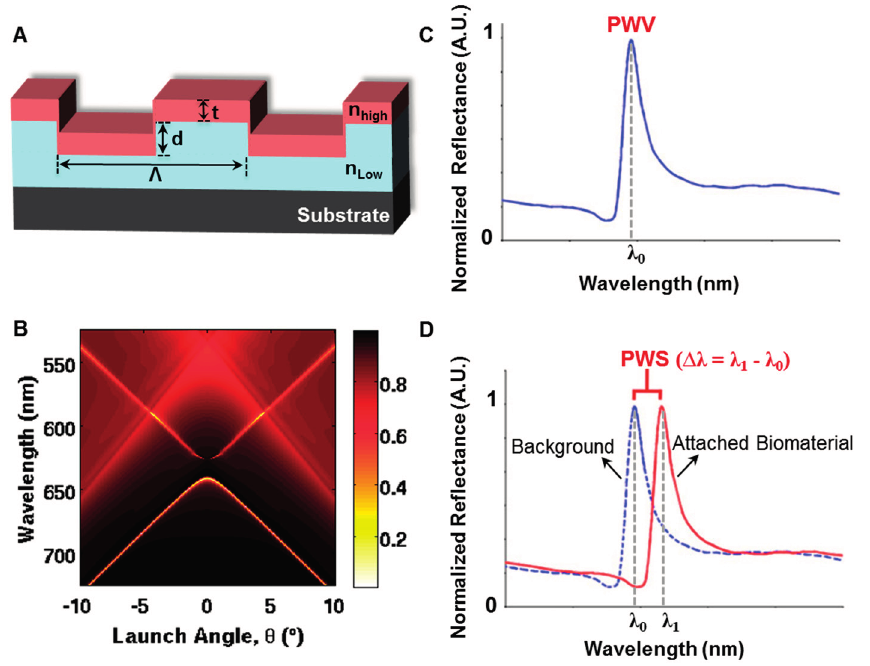
Figure 1. Photonic Crystal (PC) Surface Biosensor. ( A ) Schematic of the PC surface on a substrate with structure parameters: grating period ( Λ ), grating depth (d), refractive index (RI) of low-RI grating material (n low ) and high-RI top layer (n high ), thickness of high-RI layer (t); ( B ) Band structure of a photonic crystal biosensor calculated by FDTD simulation; ( C ) Normalized reflection spectrum from the PC surface with resonant peak wavelength value (PWV) of λ 0 ; ( D ) Peak wavelength shift (PWS) of Δλ extracted from the normalized spectra with a background pixel (PWV of λ 0 ) and a pixel with surface-attached biomaterial (PWV of λ 1 ) on the PC